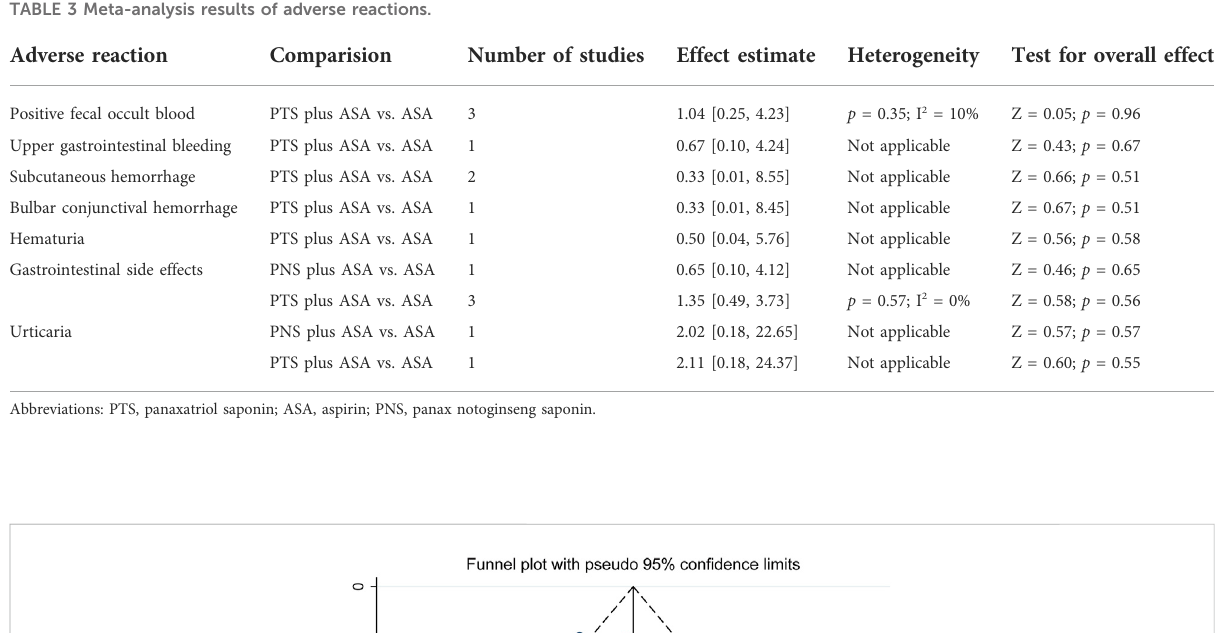
TABLE 3 Meta-analysis results of adverse reactions.